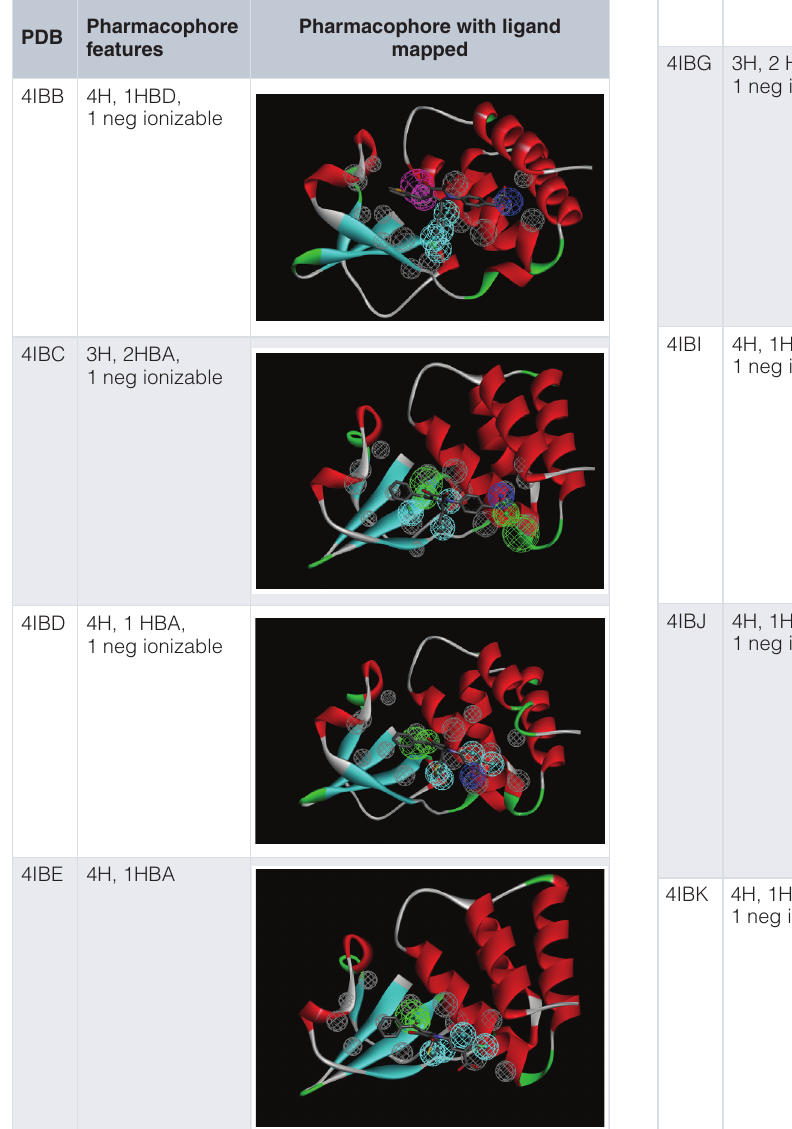
Table 1. Pharmacophores for EBOV VP35 generated from crystal structures in the protein data bank PDB. Pharmacophores were generated using the receptor-ligand pharmacophore generation protocol in Discovery Studio version 4.1 (Biovia, San Diego, CA) with minimum features (3) and maximum features (6). Pharmacophore features are Hydrophobic (H, cyan), Hydrogen bond acceptor (HBA, green), hydrogen bond donor (HBD, purple) and 1 negative ionizable (neg, blue). Excluded volumes (grey) were also automatically added. Further details on this approach are described elsewhere 20